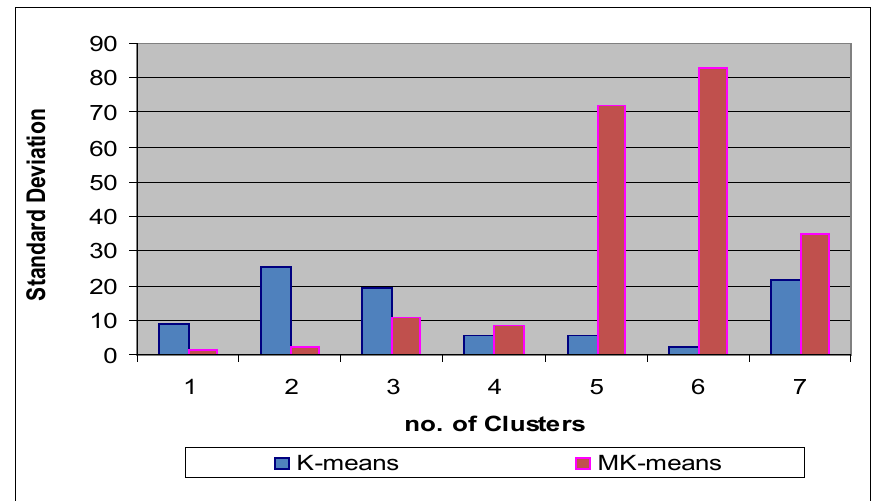
Figure 7. Difference between K-means and MK-means in 6 clusters